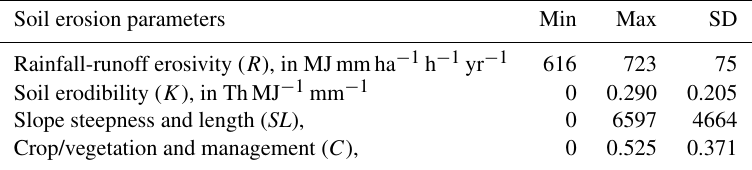
Table 1. Soil erosion parameters.